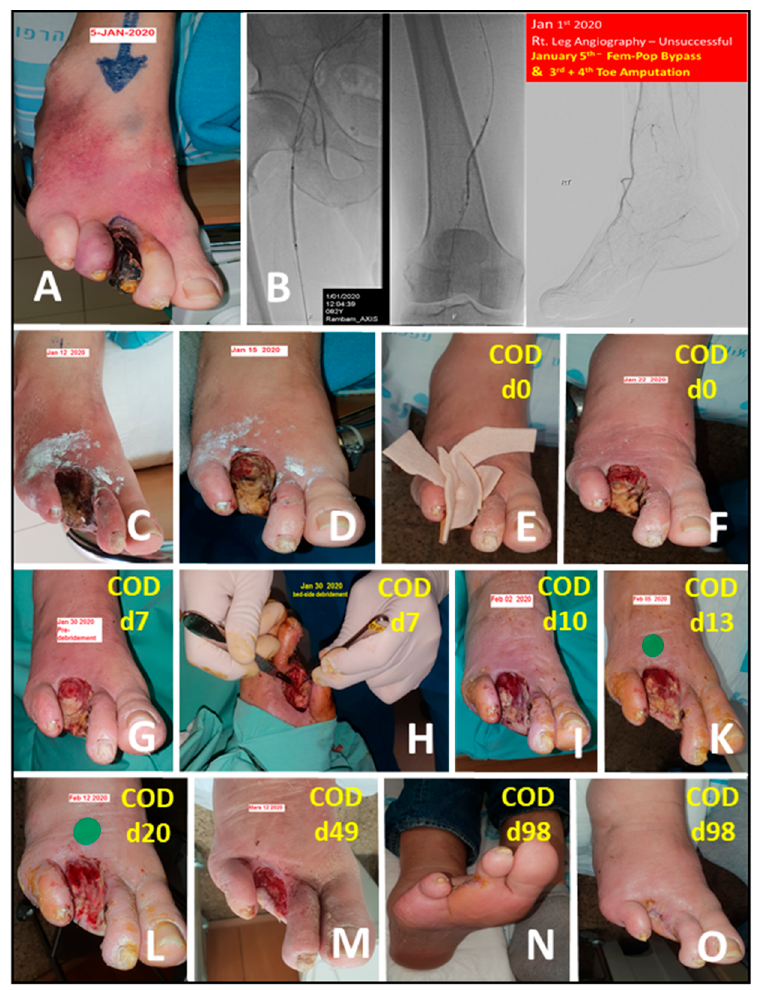
Figure 11. Wound closure following amputation due to gangrene in ischemic diabetic patient (Case Report 9). Eighty-two-year-old man with NIDDM and end stage renal disease (ESRD) on dialysis was admitted due to gangrene of the third toe and ischemia of the fourth one with cellulitis of the right foot ( A ). The patient had peripheral vascular disease (PVD) with intermittent claudication and no palpable pulses distal to the femoral. Attempted angiography was unsuccessful due to hard calcifications of the arteries ( B ). Subsequent femoral-popliteal bypass surgery was successful with good improvement of the blood flow and temperature to the level of the midfoot. The surgery was followed by third and fourth ray amputation in the same surgery. Following surgery the amputation wound was treated with antibiotic and twice a day chlorine based solution and was still ischemic ( C , D ). On the ninth day post-surgery antibiotic treatment was stopped and COD was begun ( D , E , marked as COD d-0). One and two weeks later a progression or the granulation tissue is observed ( F , G ). For the most part the wound was still filled with necrotic tissue and bed side debridement was attempted with minor improvement ( H ). COD was used again and three days, one week, two weeks, and six weeks later further progression of the wound was seen ( I , K – M ). On a follow up visit, 14 weeks from the beginning of COD dressing, the wound was closed ( N , O